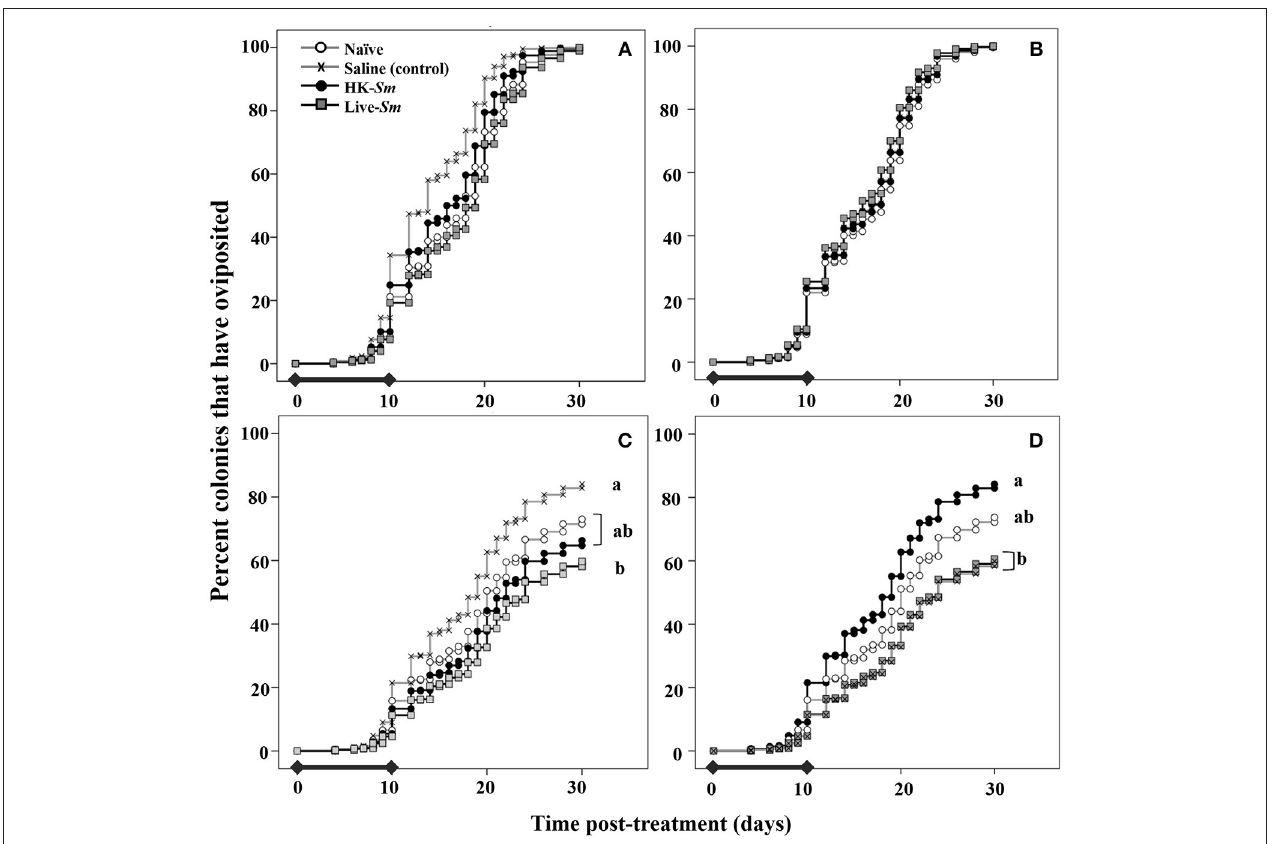
FIGURE 4 | Top (A,B) Onset of oviposition curves derived from model 1 as a function of king treatment (A) and queen treatment (B) . The legend in the top left corresponds to treatment for all four graphs. The black bars overlaid on the X-axis show the period during which the steepest decline in reproductive survival occurred ( Figure 3 ). This period coincided with the time at which parents are allocating resources to the various demands. For both parental treatments, there was no significant difference in the onset of oviposition. Onset of oviposition was primarily influenced by intrinsic traits (mass, COO, Table 1 ). Bottom (C,D) depict the likelihood of oviposition as a function of king treatment (C) and queen treatment (D) . Colonies headed by saline-injected kings were significantly more likely to oviposit than Live- Sm kings (C) . HK- Sm queens were significantly more likely to oviposit than saline and Live- Sm queens (D) . In D , the Live- Sm and saline curves are